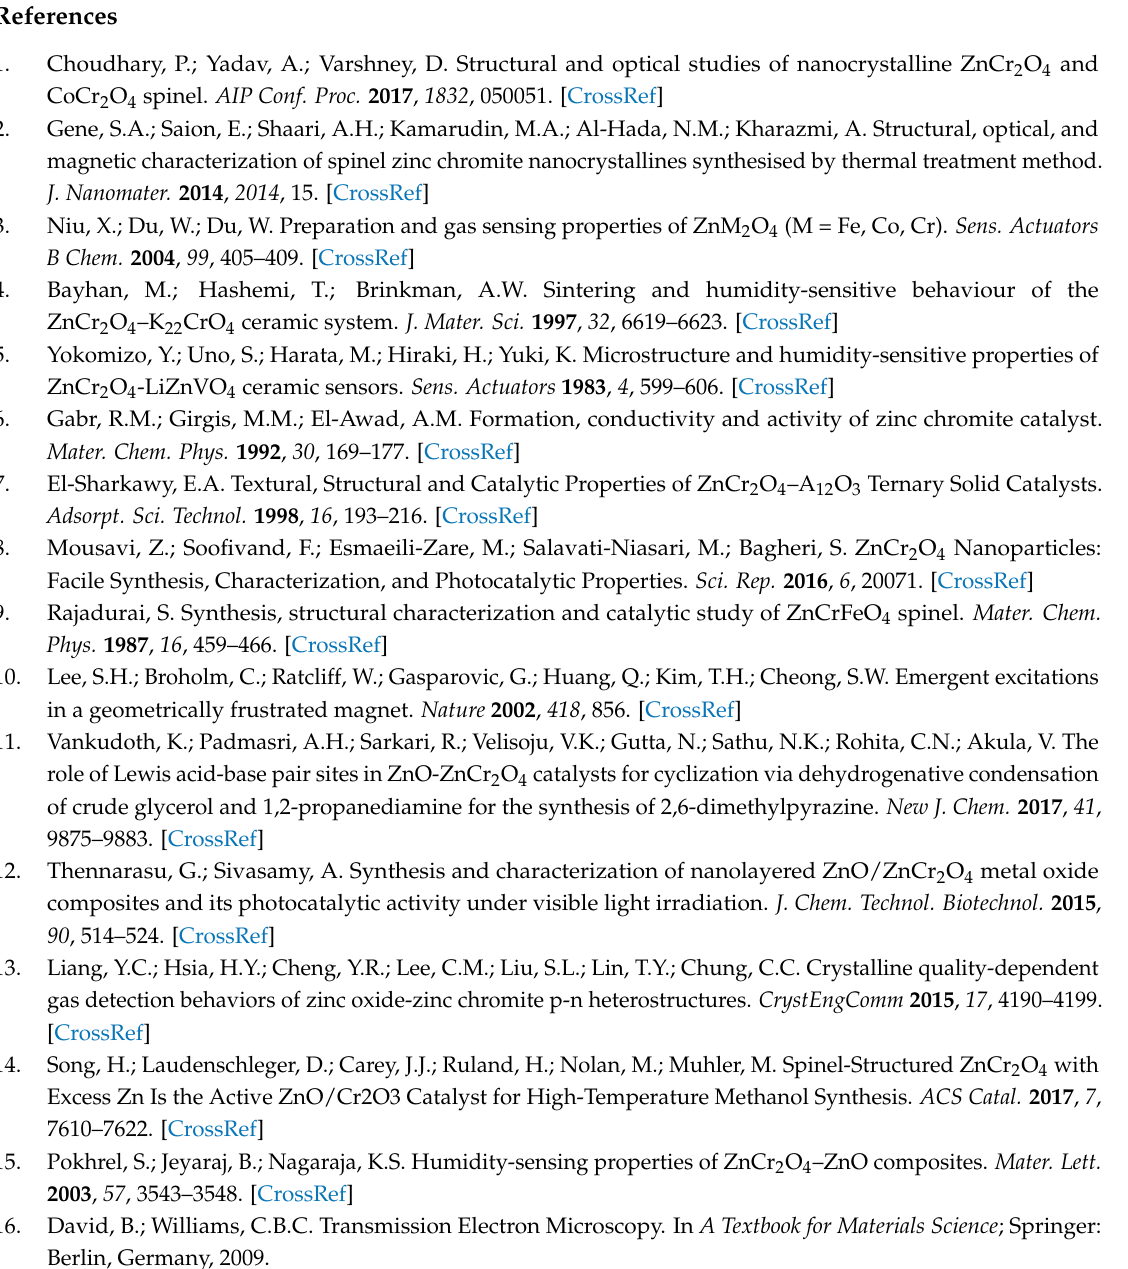
Table S2: Unit cell parameter of ZnCr 2 O 4 from XRD experiment and literature. α = β = γ =90 ◦